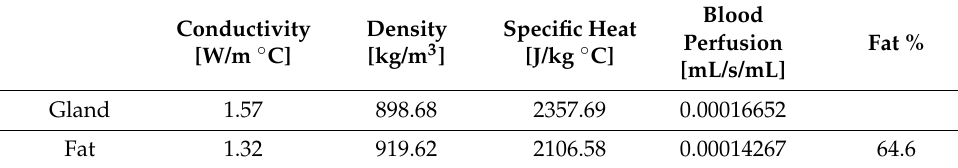
Table 7. Estimated specific breast parameters (patient #1).